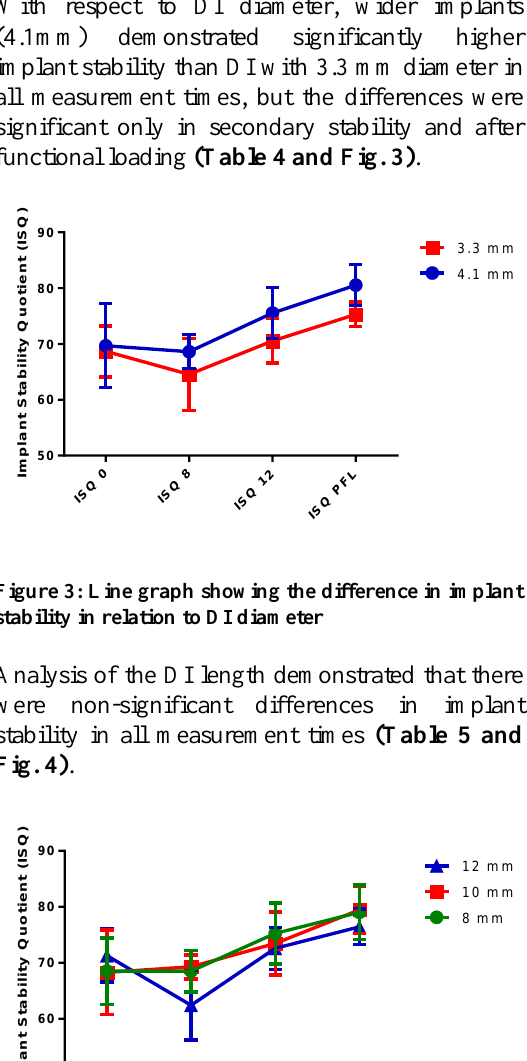
Figure 2: Line graph showing the difference in implant stability in the maxilla and the mandible